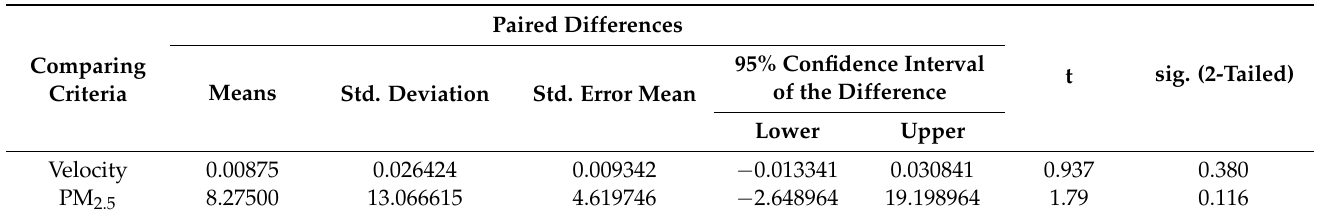
Table 3. P1 and P2 simulated data were paired with measured data for the sample test.